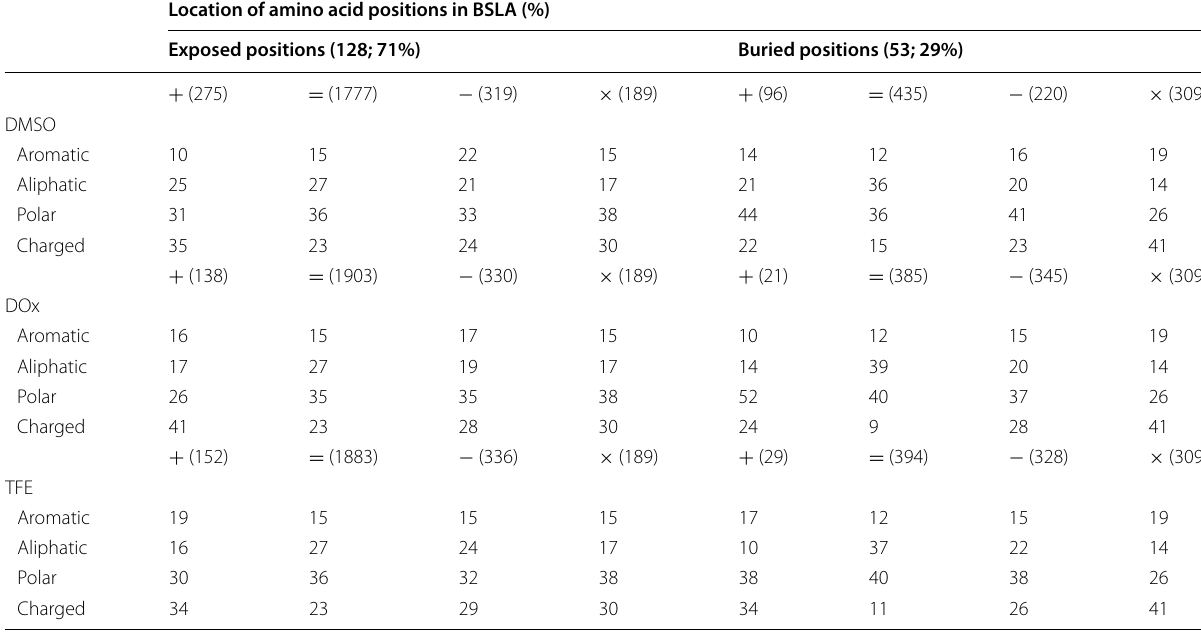
Table 3 Effect of amino acid location (buried, exposed) on organic solvent resistance of BSLA when replacing each type of amino acid in BSLA